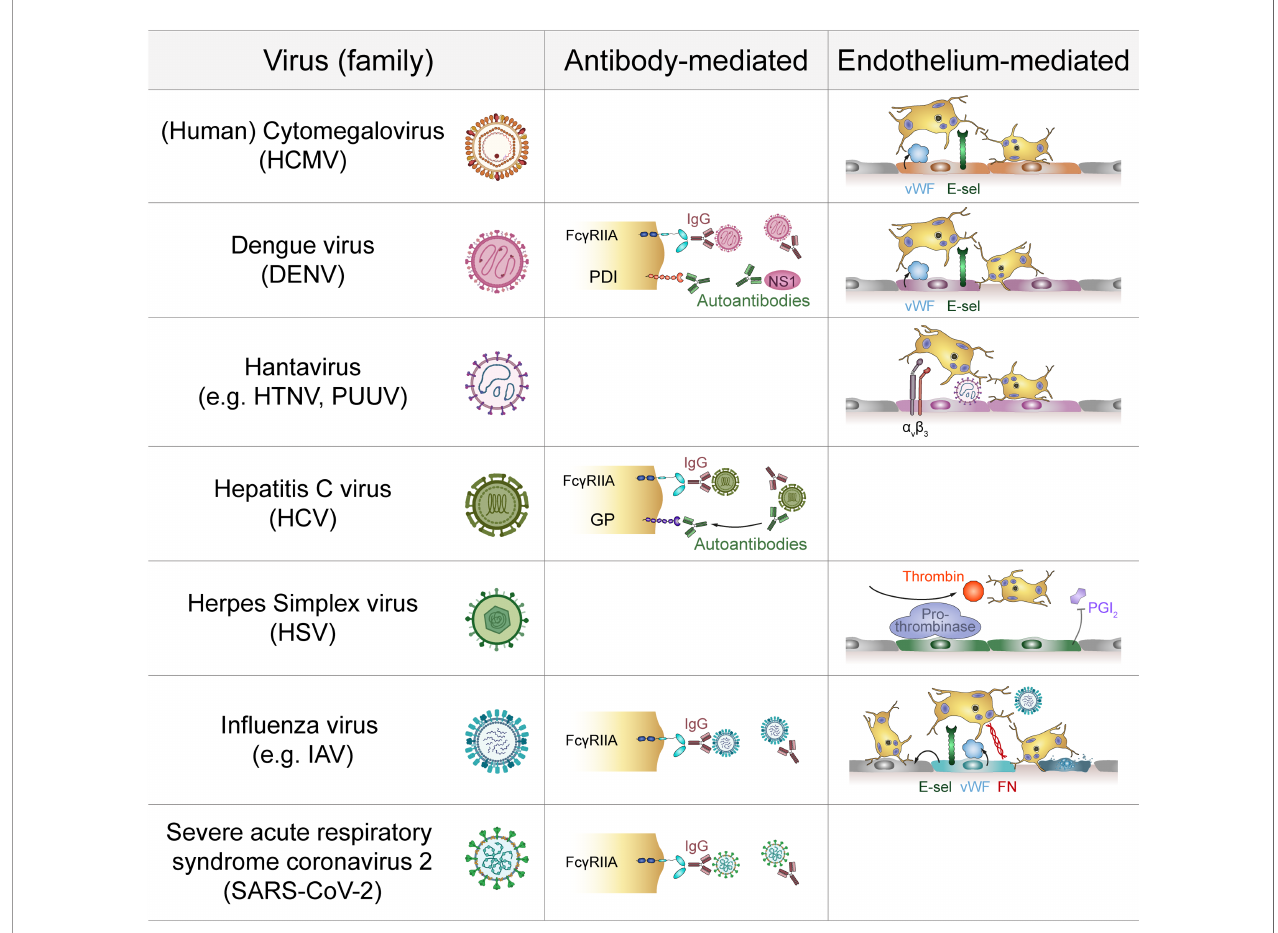
FIGURE 2 | Indirect platelet-virus interactions. Several virus families interact with platelets via the formation of virus-IgG complexes that are recognized by platelet Fc g RIIA. Antibodies against viral proteins may also act as autoantibodies by targeting platelet membrane components. Additionally, infection of endothelial cells induces expression of adhesive molecules that promote platelet adhesion. Infected endothelial cells also facilitate pro-thrombinase activity to modulate platelet activation. E-sel, E-selectin; Fc g RIIA, Immunoglobulin g Fc region receptor IIA; FN, Fibronectin; GP, Glycoprotein; HTNV, Hantaan virus; IAV, In fl uenza A virus; IgG, Immunoglobulin G; NS1, Non-structural protein 1; PDI, Protein disul fi de isomerase; PGI 2 : Prostaglandin I 2 (prostacyclin); PUUV, Puumala virus; vWF, von Willebrand